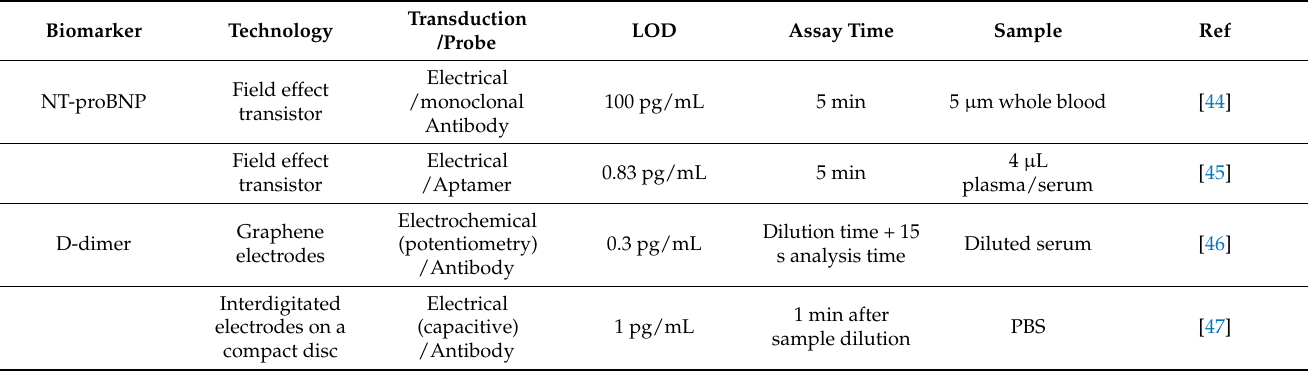
Table 2. Examples of biosensor technologies currently under development that satisfy the criteria for rapid testing (<10